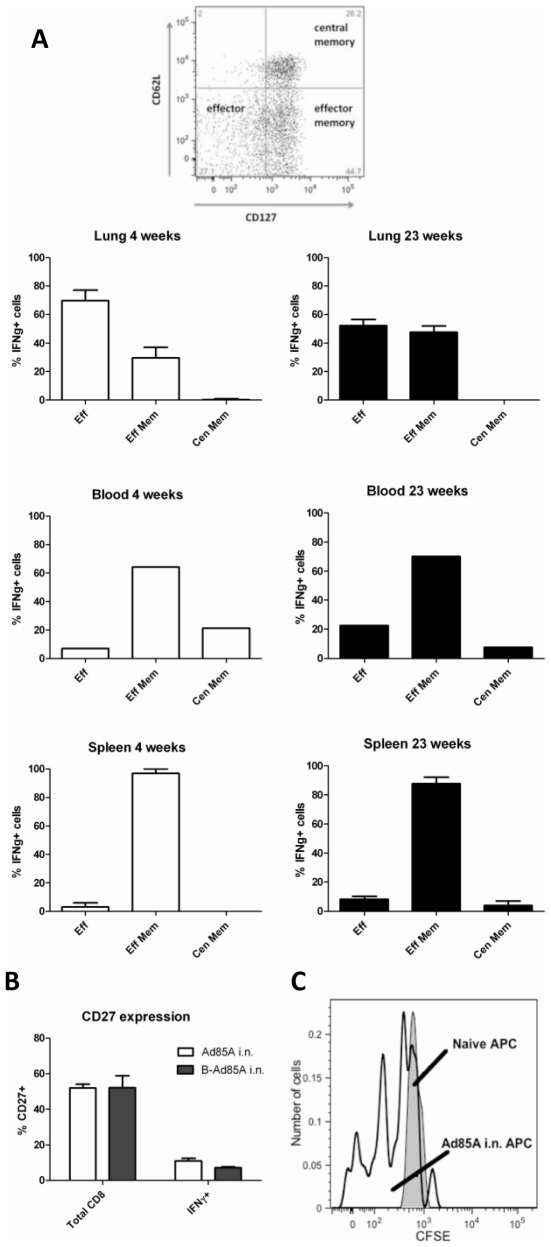
Phenotype of antigen-specific cells following intranasal immunization with Ad85A.Mice were immunized as described in the legend to Fig. 2 and lung cells stained for CD8, IFNγ, CD62L and CD127 (A) or CD27 (B). All results are from Ad85A i.n. mice at 4 and 23 weeks. Similar data were obtained from B-Ad85A i.n. mice. Results are expressed as the mean +/− SEM from three or four mice except for blood where the PBMCs from three/four mice were pooled. Similar results were obtained from two independent experiments. (C) Persistence of antigen 85A in the lungs. Cells from the lungs of mice immunized 23 weeks previously with Ad85A i.n. (open histogram) or naïve control mice (shaded histogram) were used as APCs and co-cultured with CFSE-labelled 85A-specific splenic T cells. Cells were recovered at day 5 and stained with H-2Ld 85A peptide 70–78aa (MPVGGQSSF) tetramer. The histogram shows the CFSE profile of 85A tetramer positive CD8 cells. The result of one representative experiment of three is shown.